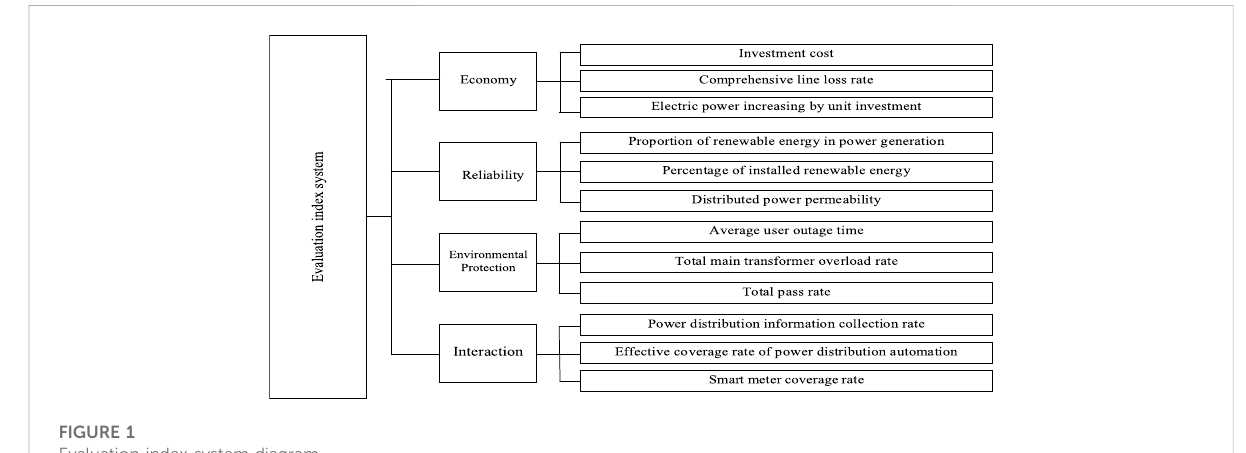
FIGURE 1 Evaluation index system diagram.